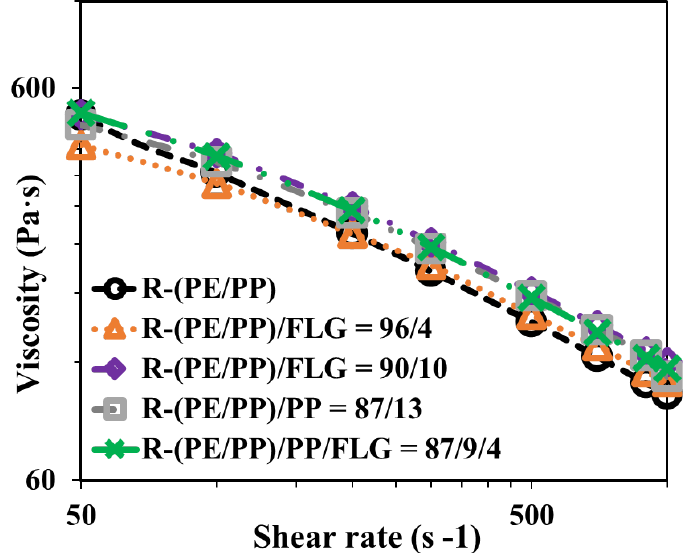
Figure 1. Apparent viscosity of the neat R-(PE/PP) and the additive (FLG, prime polymer) filled R-(PE/PP) samples at 200 ◦ C as a function of shear rate.